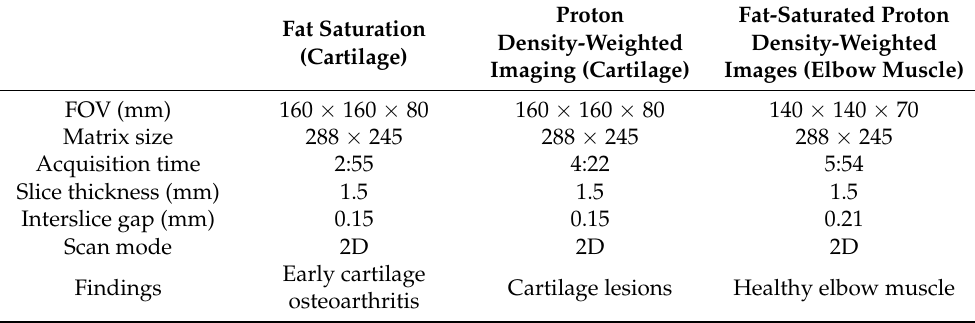
Table 1. Acquisition parameters for analyzed datasets of articular cartilage and elbow muscle.